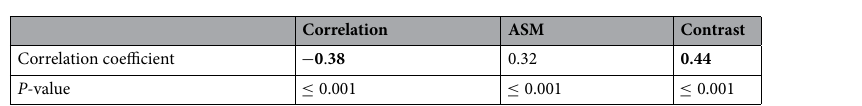
Table 7. Pearson correlation between concepts and network prediction. Significant values are in bold.